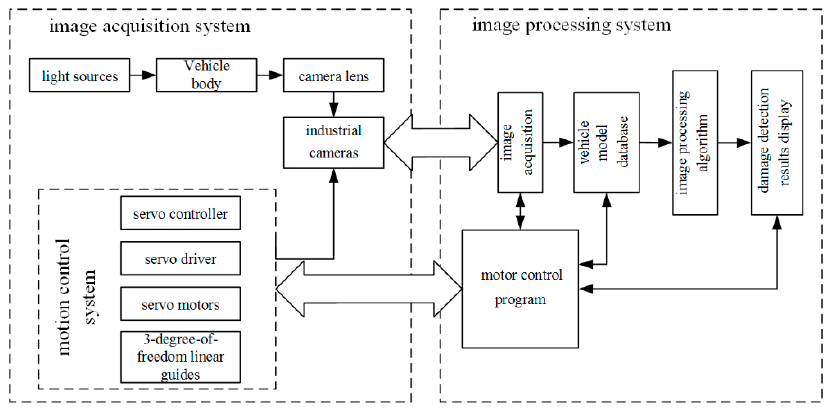
Figure 3. Overall architecture of the vehicle automatic inspection system.